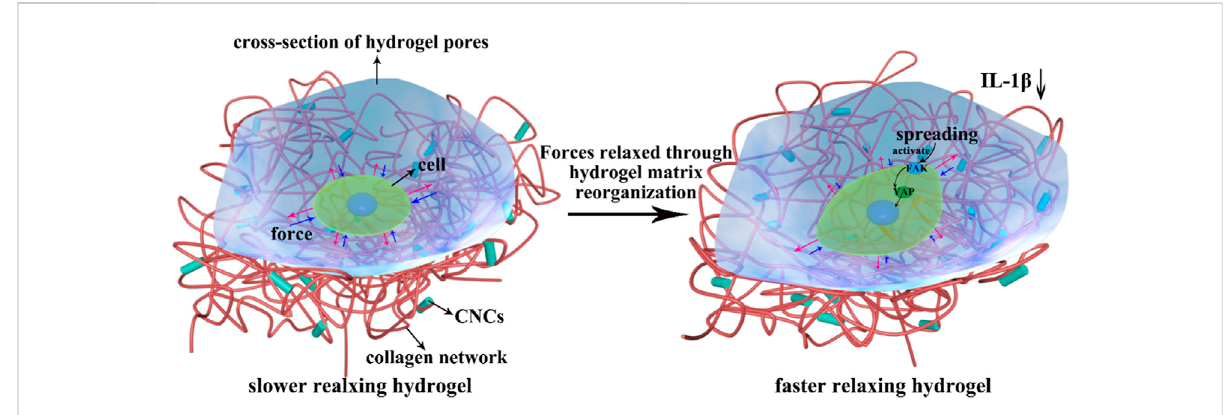
FIGURE 10 Overview of CNC/COL hydrogel stress relaxation impacting chondrocyte behavior through the mechano-transduction of FAK and YAP. Red arrow represents the force exerted by chondrocytes and blue arrow represents the resisting force applied by hydrogel